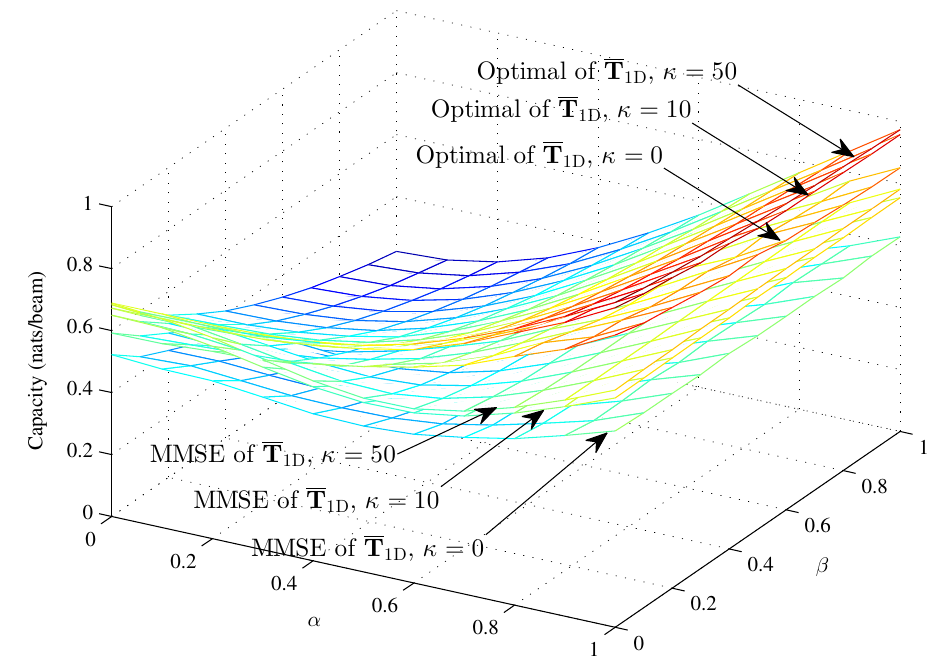
Figure 7. The optimal capacity and MMSE capacity of hybrid 1D beams with γ = 1 and N = 100 ( κ = 0, κ = 10 and κ = 50) versus α and β